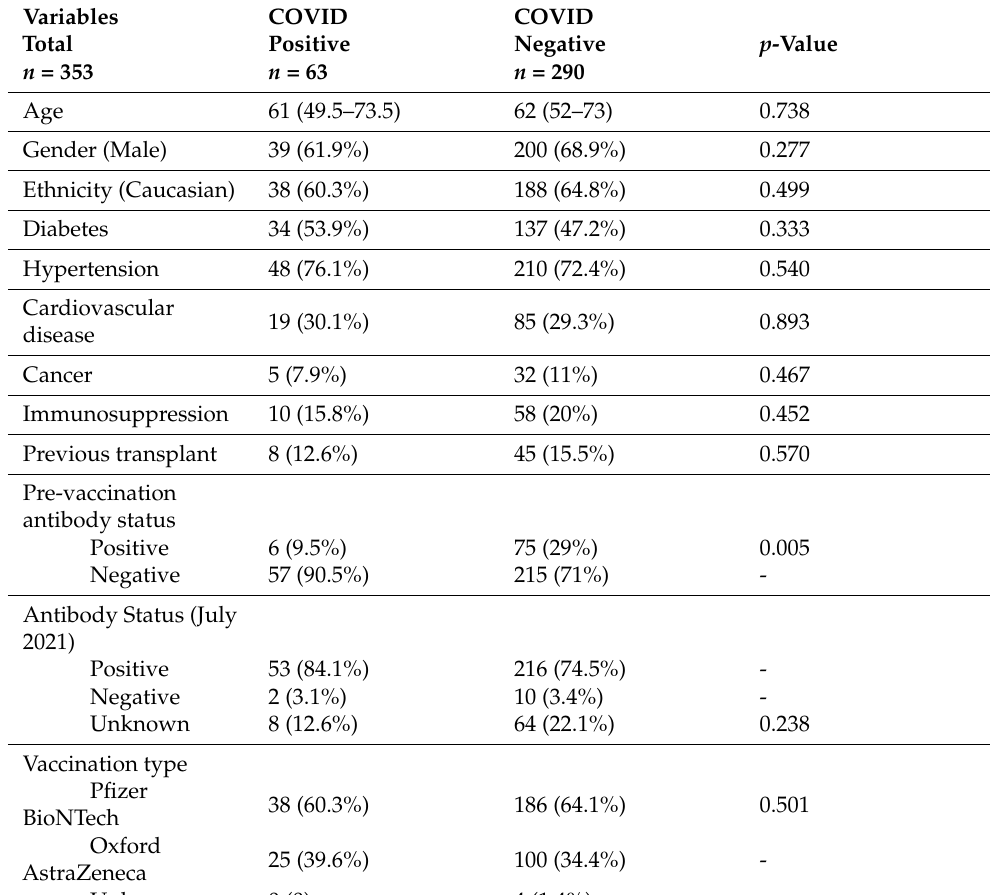
Table 3. Comparison of characteristics of patients who have received double dose vaccination by June 2021, based on breakthrough COVID-19 infection between April 2021 and January 2022.